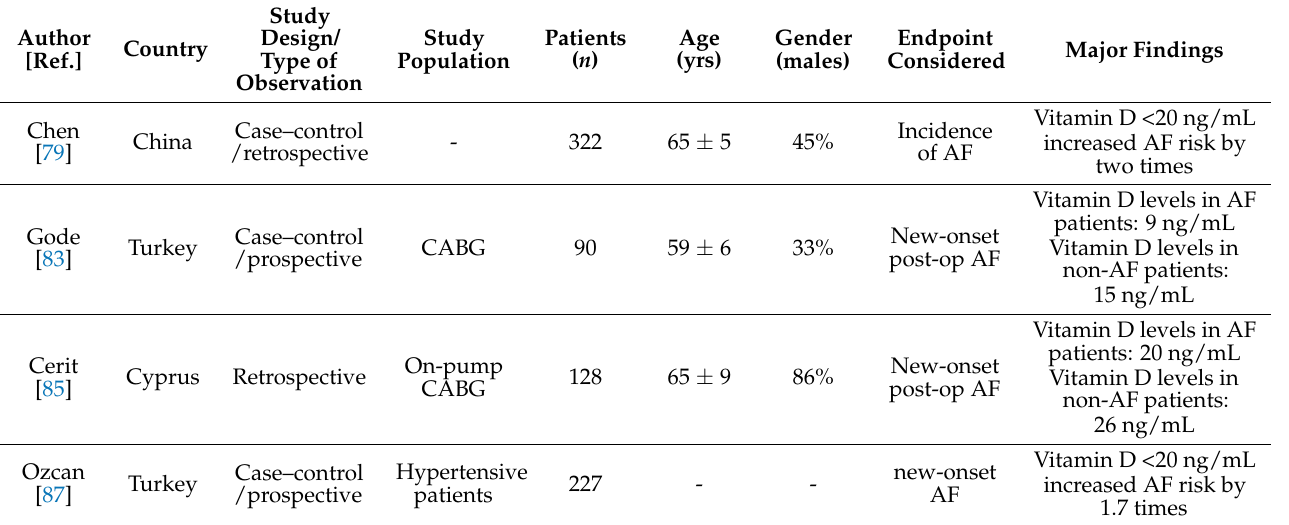
Table 4. Some of the major studies on the clinical relevance of vitamin D levels in atrial